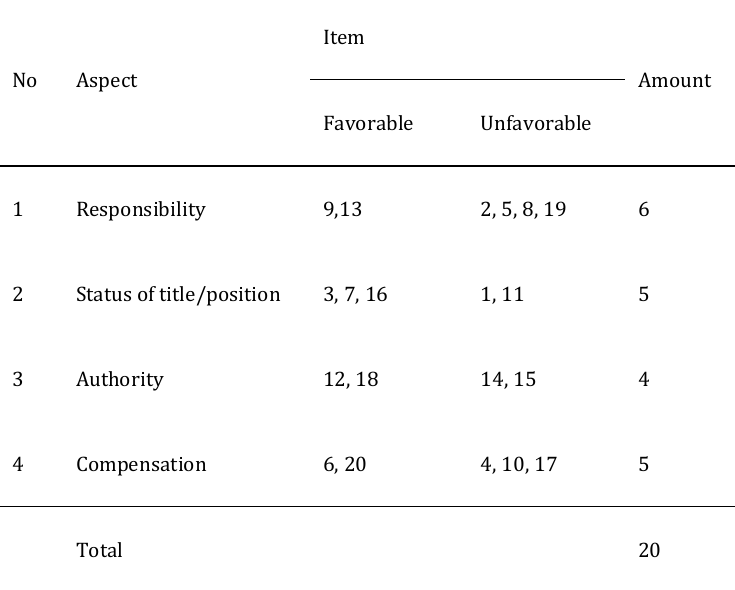
Table 6 The numbering of the career development perception scale after trying